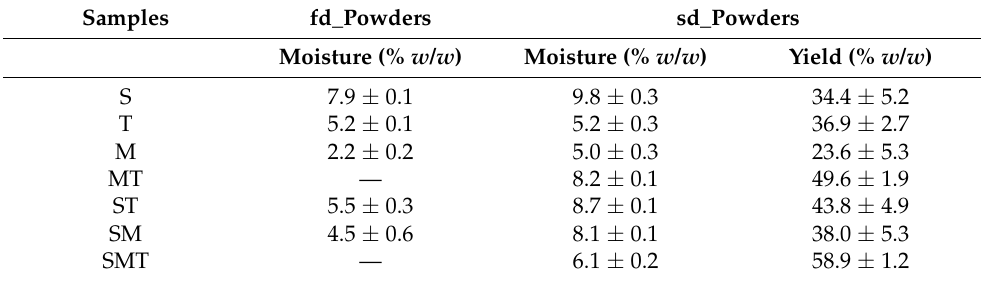
Table 1. List of abbreviations used in the text. Samples fd_Powders sd_Powders Moisture (% w / w